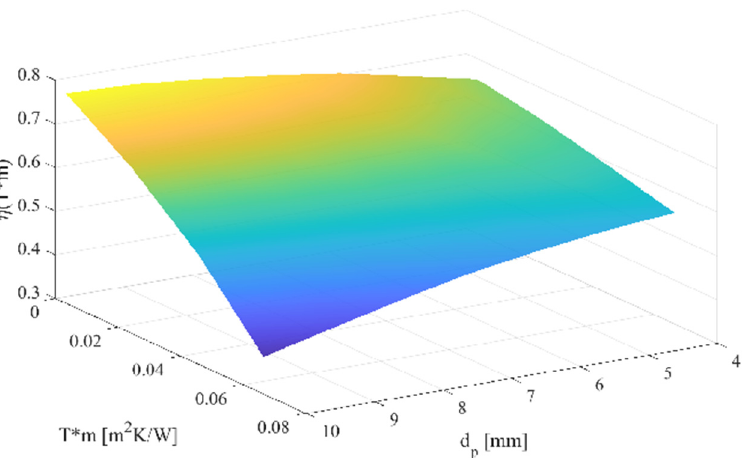
Figure 14. Characteristic thermal efficiency curve (cid:2015)((cid:1846) ∗ (cid:1865)) as a function of the working pipe